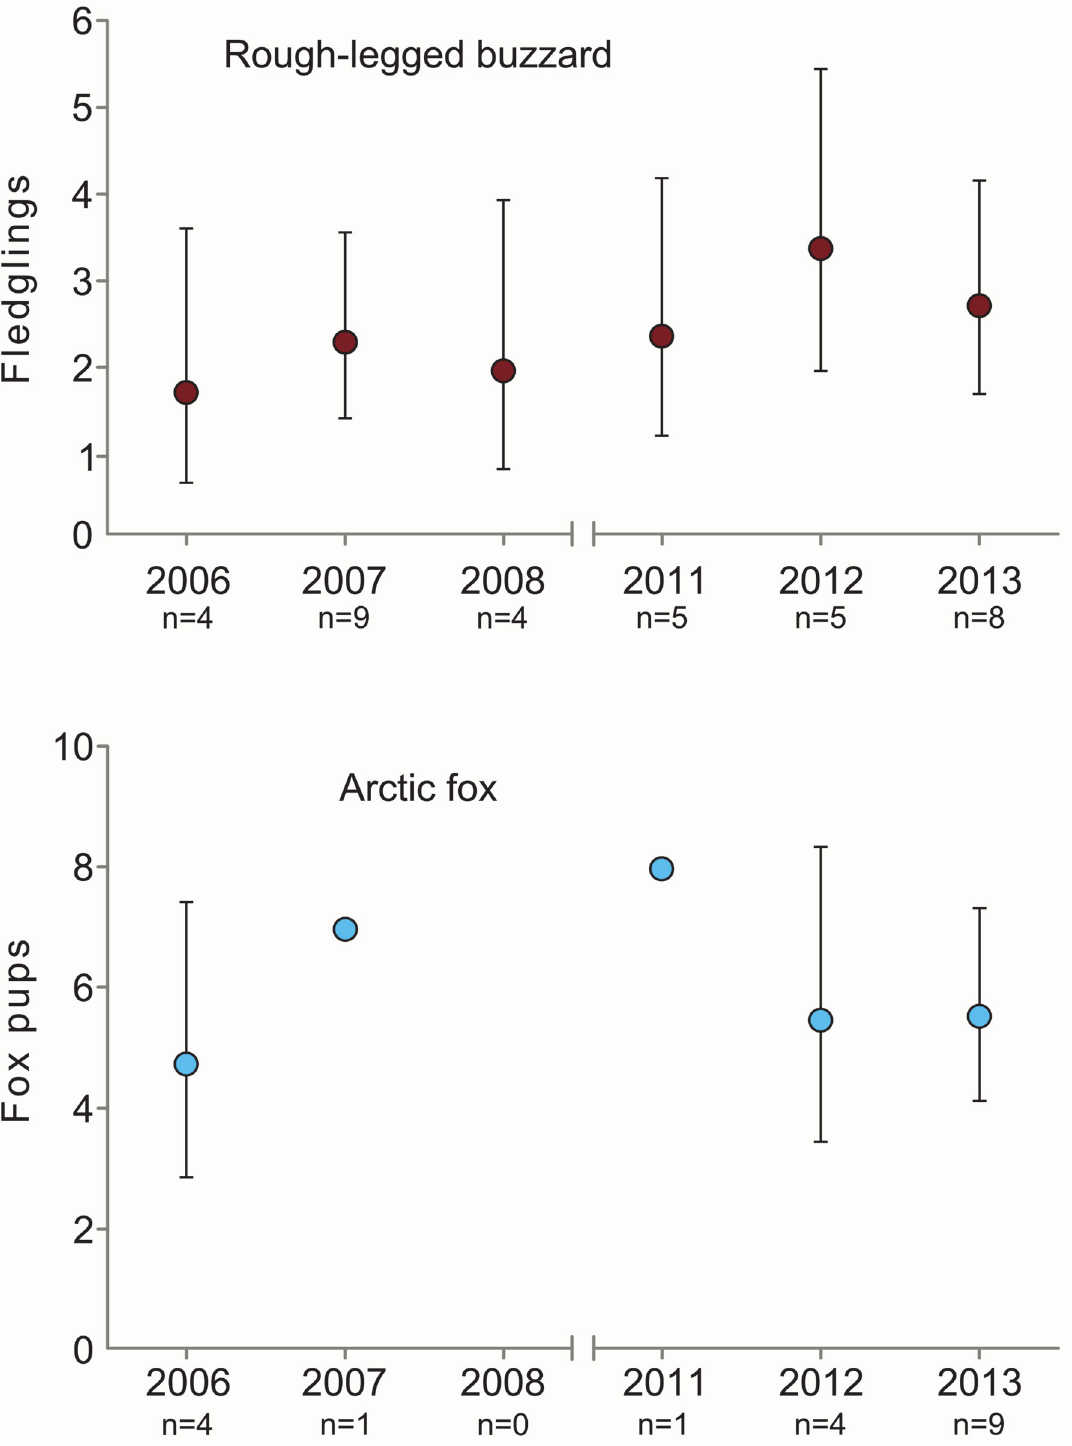
Fig 3. Productivity of rough-legged buzzards and arctic foxes on Kolguev Island, Russia. n — number of nests/dens with estimated productivity in each year. Error line — 95% CI.